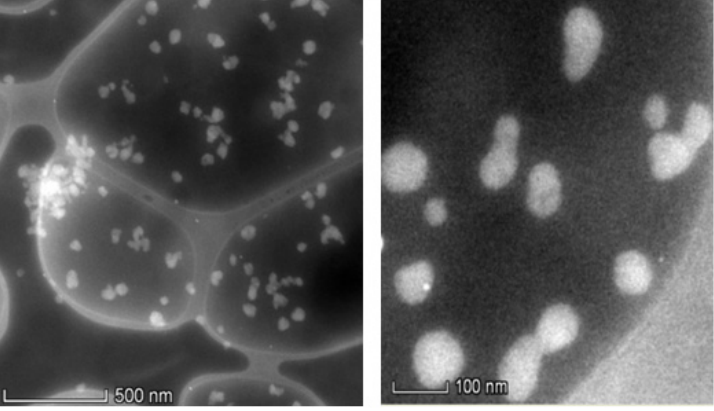
Figure 9. TEM images of colored BVD 141 dyed polymeric particles after thermal treatment at different scale bars.